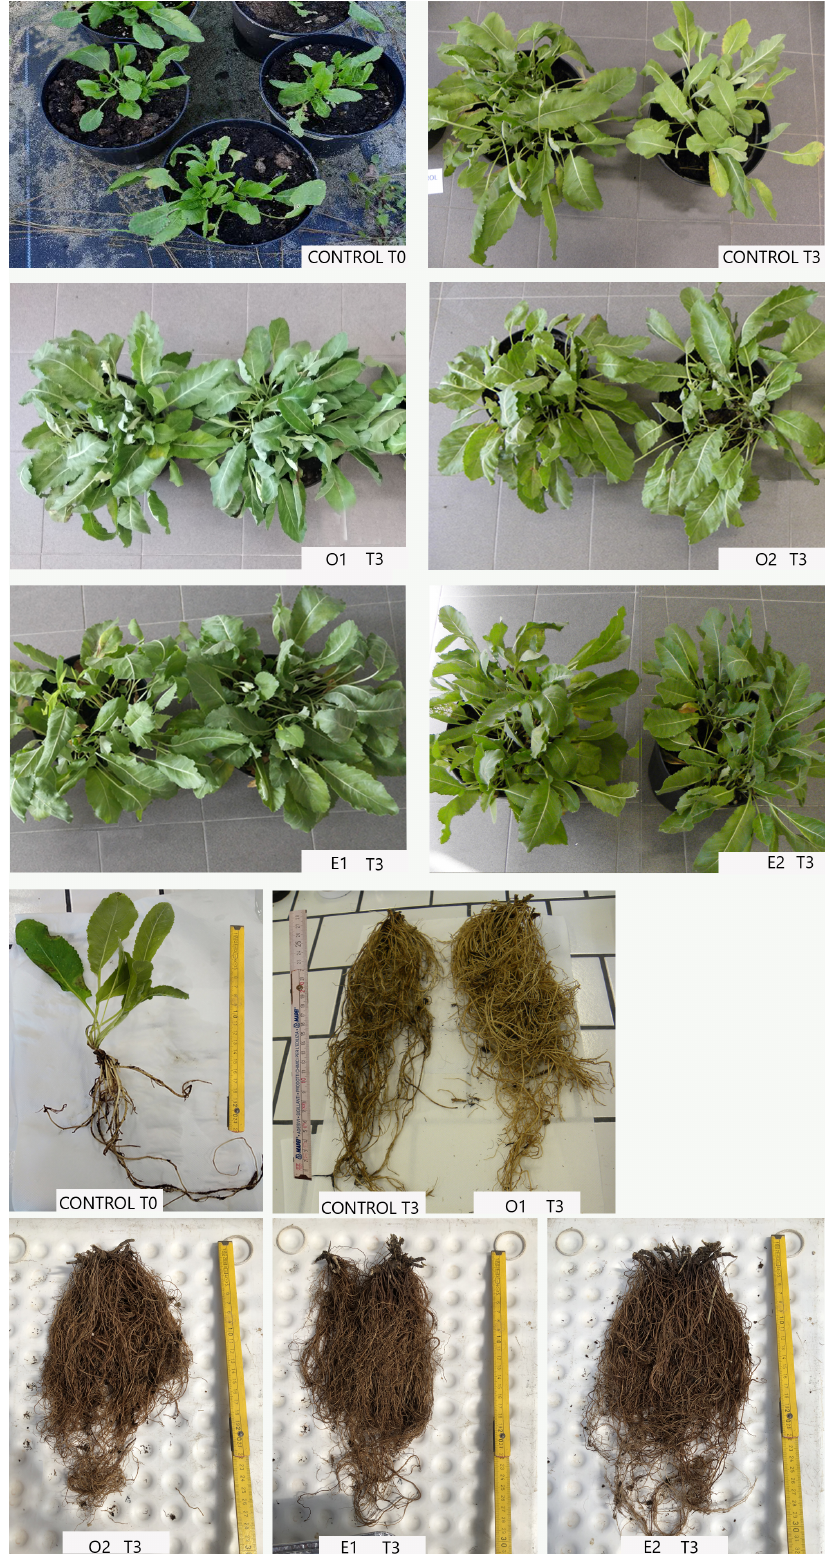
Figure 3. P lants and roots grown at different concentrations of Effective Microorganisms and Olive Mill Wastewater, at time T0 and T3 (final